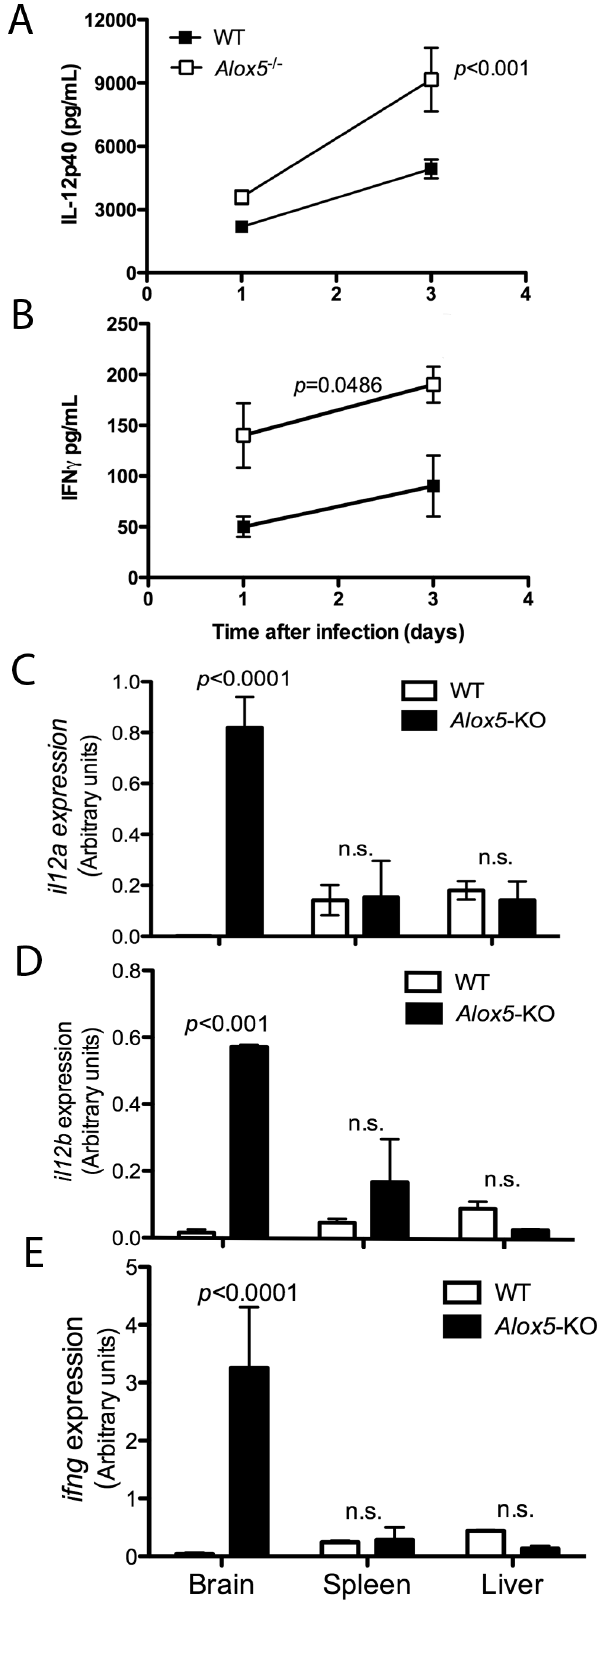
Figure 2. Enhanced cytokine expression during P. berghei ANKA infection in 5-LO-deficient mice. C57Bl/6 WT and Alox5 2 / 2 ( n =4 mice/group) mice were infected i.p. with P. berghei ANKA strain. At 1 and 3 days after infection, animals were bled and serum levels of IL- 12p40 ( A ) and IFN- c ( B ) were determined by ELISA. Five days after infection, mice were sacrificed and brains, livers and spleens harvested. Tissues were homogenized, total RNA extracted and reverse tran- scripted for real-time RT-PCR determination of il12a ( C ), il12b ( D ) and ifng ( E ) expression. Data shown are representative of one out of three independent experiments performed. Statistical differences were determined using Mann Whitney